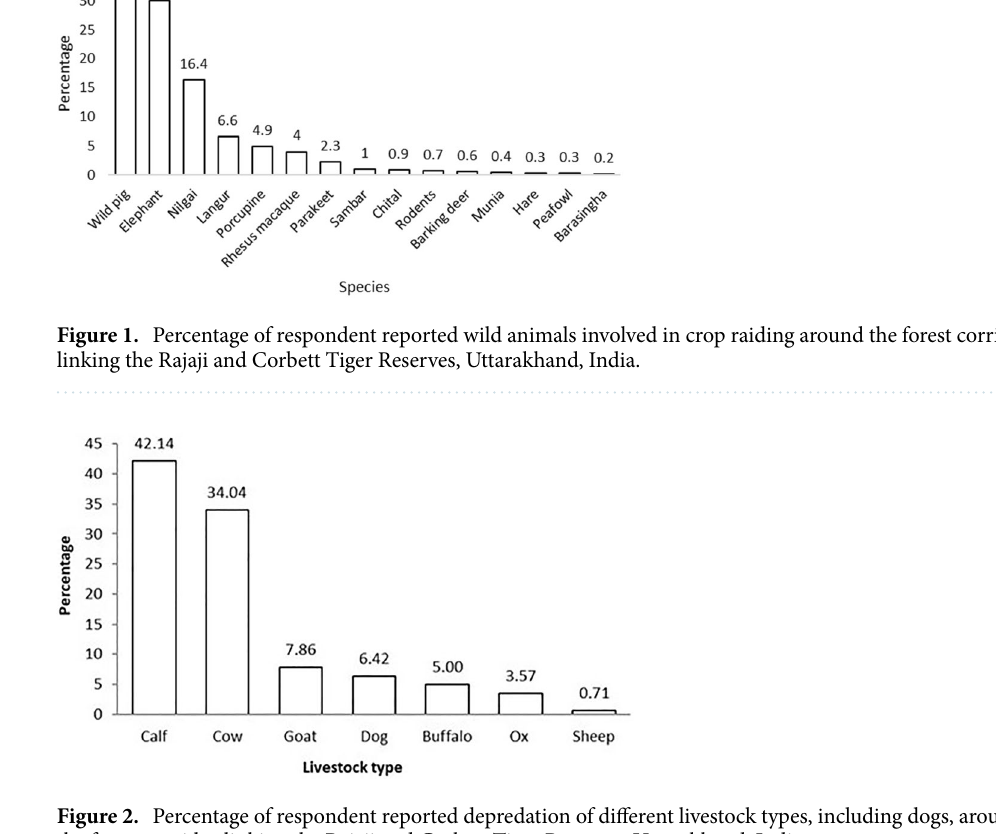
Figure 2. Percentage of respondent reported depredation of different livestock types, including dogs, around the forest corridor linking the Rajaji and Corbett Tiger Reserves, Uttarakhand,